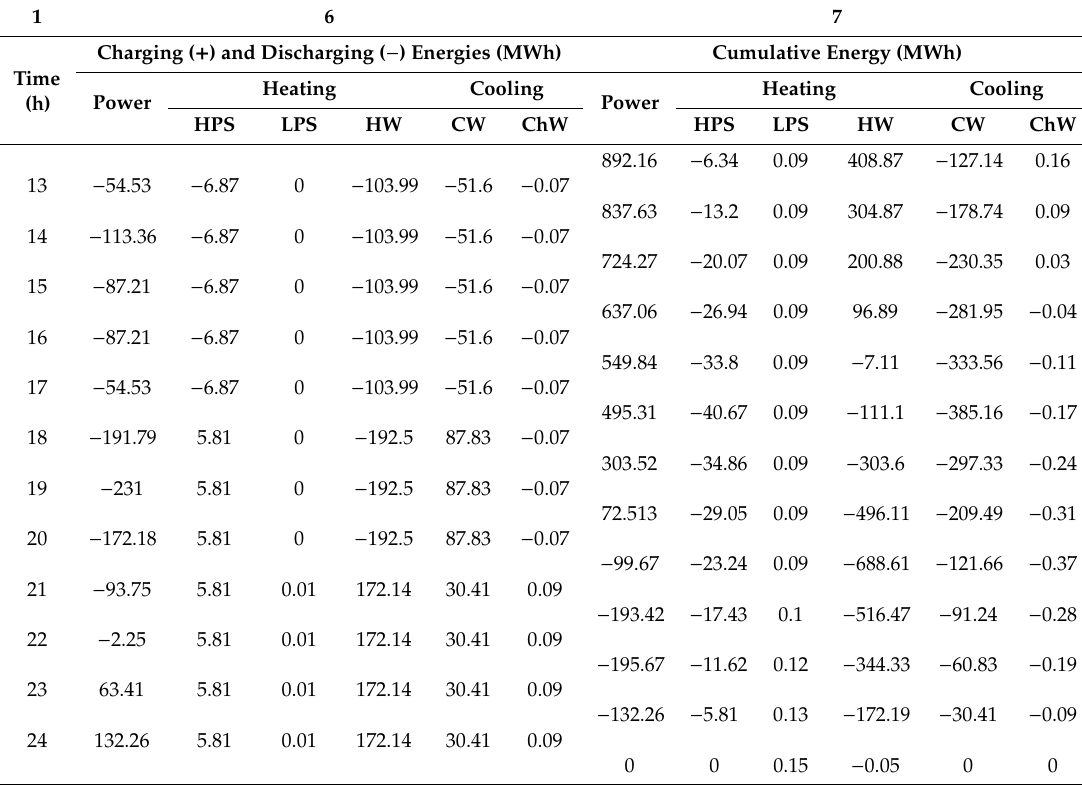
Table A14. TriGenSCA after iteration from time 13 to 24